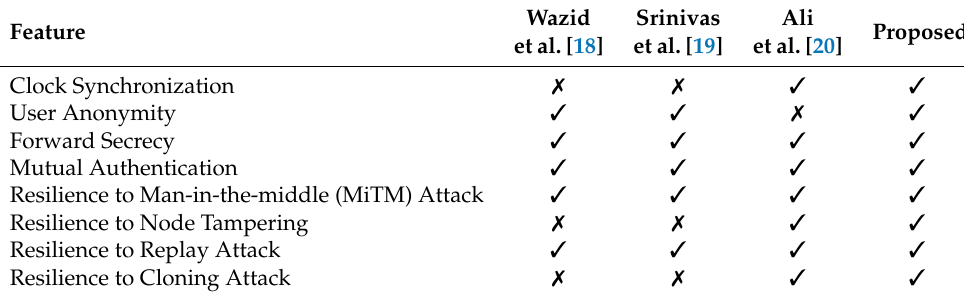
Table 4. Comparison of features for various UAV authentication